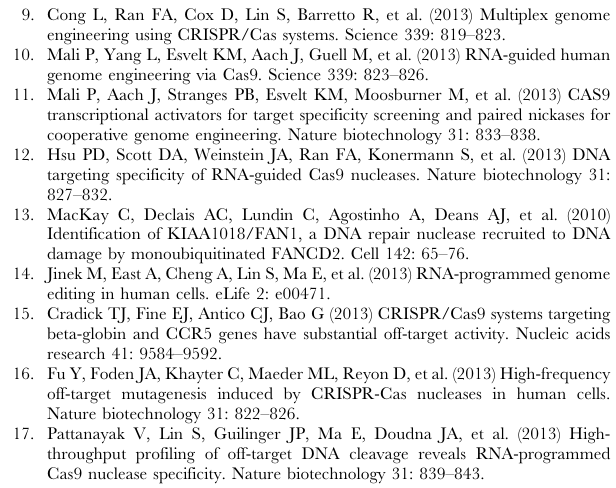
Figure S3 Comparison of the mutation efficiency be- tween SEC-C and double transfection. ( A ) PCR was performed using DNA isolated from a pool of U2OS SEC-C that had been either mock transfected (lane 1 and 2) or transfected with sgRNA against NM_024631 (lane 3 and 4), and from U2OS cells that had been transfected with a mixture of 10 m g CAS9 Flag plasmid and sgRNA against NM_024631 (lane 5 and 6). PCR products were purified and digested or not with the indicated enzyme. (B) The relative intensity of the bands in lanes 4 and 6 was quantified in four independent experiments using Image Lab software. Values in the histogram represent the relative intensity of the top band per lane, expressed in percentage after background subtraction (lane 2, band 1 intensity). Data are represented as mean 6 STDEV, n= 4 and p value = 0.0016. Experimental significance was calculated using a paired T-test; **, p , 0.01; ( C ) Table used to generate the histogram in (B). (TIF) Figure S4 Sequence analysis of U2OS FAN1 2 / 2 clones. ( A ) Mutations identified from the PCR fragments generated from the indicated single cell colonies with the primers described in Figure 2. ( B ) Predicted translation of the Open Reading Frames corresponding to the sequences identified in (A) (TIF) Figure S5 Complementation of the U2OS FAN1 2 / 2 cells. (A) Schematic diagram of the protocol used to flip-out the integrated Cas9-Flag from clones 1 and 2. ( B ) Clonogenic survival analysis of U2OS FAN1 + / + (clone 2) U2OS FAN1 2 / 2 (Clone 3) and U2OS FAN1 2 / 2 + FAN1 (Clone 3 complemented) cell lines